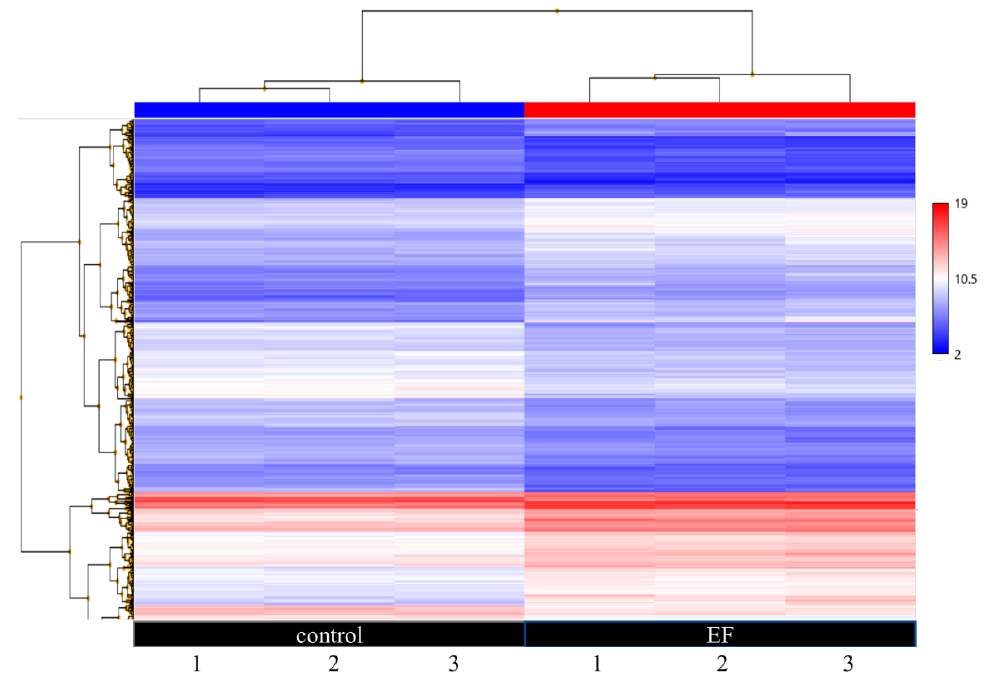
Figure 2. Hierarchical illustration of differentially expressed genes in hTCEpi cells after treatment with AC EFs for 24 h. Both two-fold upregulated and downregulated genes were clustered. Untreated hTCEpi cells served as control. After 24 h of treatment with AC EFs, RNA was isolated and transcriptome-wide gene level expression profiling was performed using Clariom ™ S arrays. Affymetrix ® Transcription Analysis Console TM (TAC) software (v.4.0.1.36) was used for array scanning, data analysis, signal estimation, and quality control functionality for the expression arrays, which also allow statistical analysis and provide a list of differentially expressed genes. Expression level analysis was performed using the normalization method based on the processing algorithm called the robust multi-array average (RMA), which was improved by Signal Space Transformation (SST-RMA, Affymetrix). Each array was performed in triplicate. Blue indicates a relatively low expression, whereas red indicates a relatively high expression.